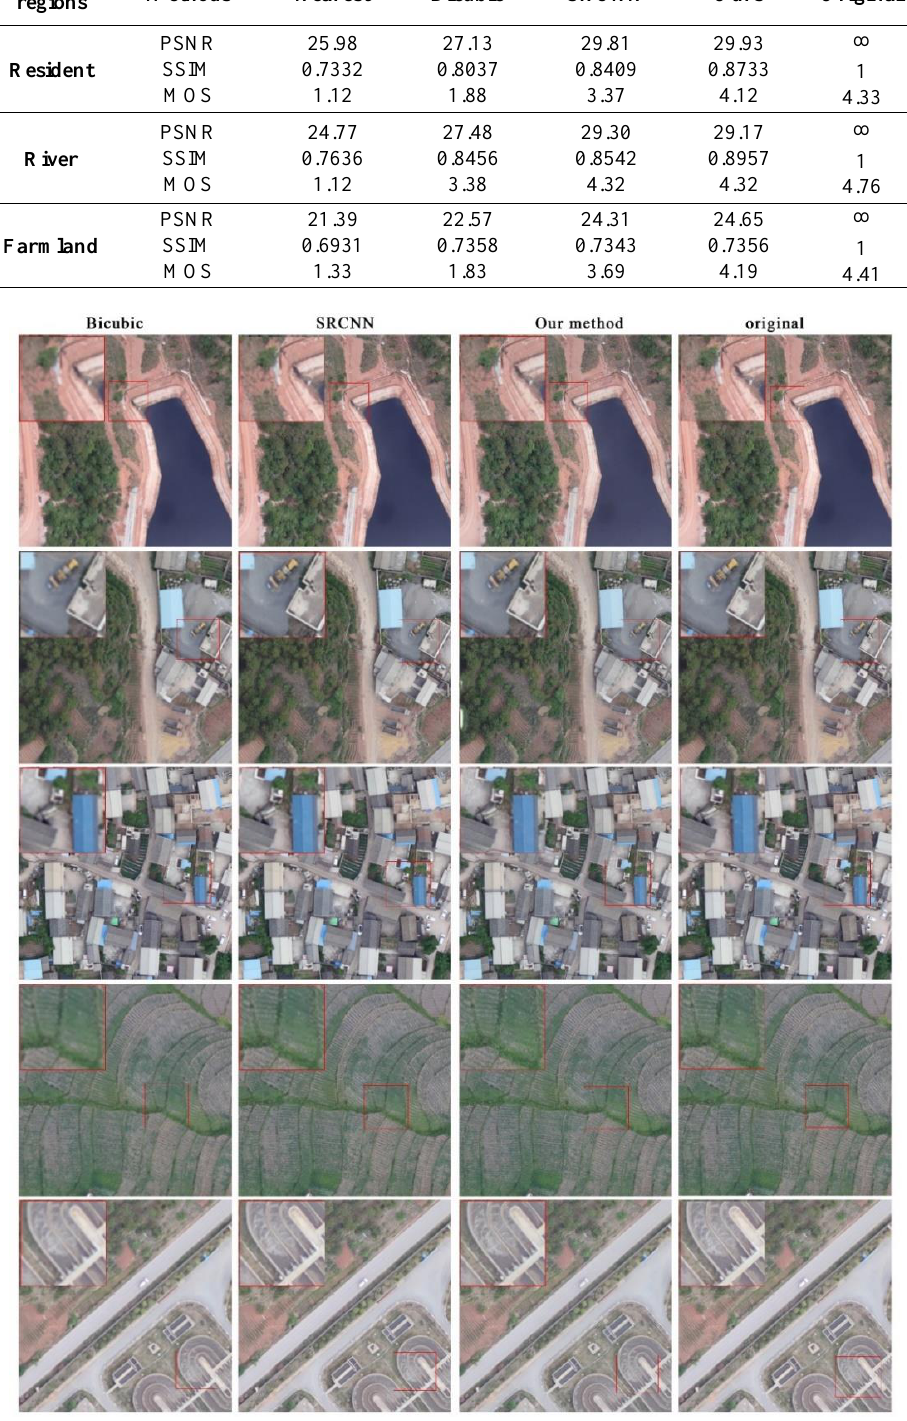
Figure2. Comparison of using bicubic interpolation, SRCNN, our SR-GAN method and original HR